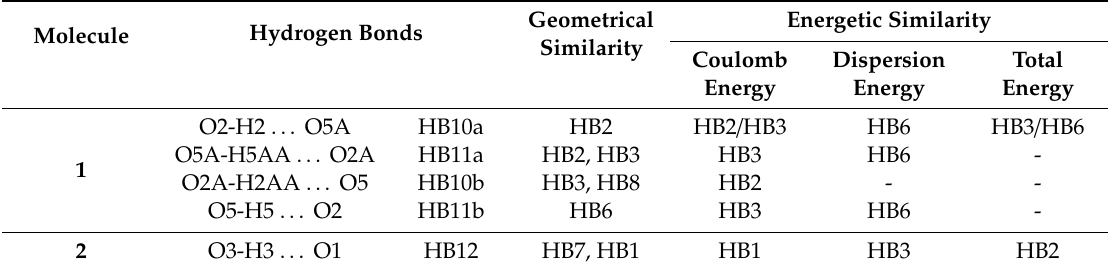
Table 4. Geometrical and energetic similarities of the hydrogens bonds of 1 and 2 with a comparison to vitamin D analogues. Molecule Hydrogen Bonds